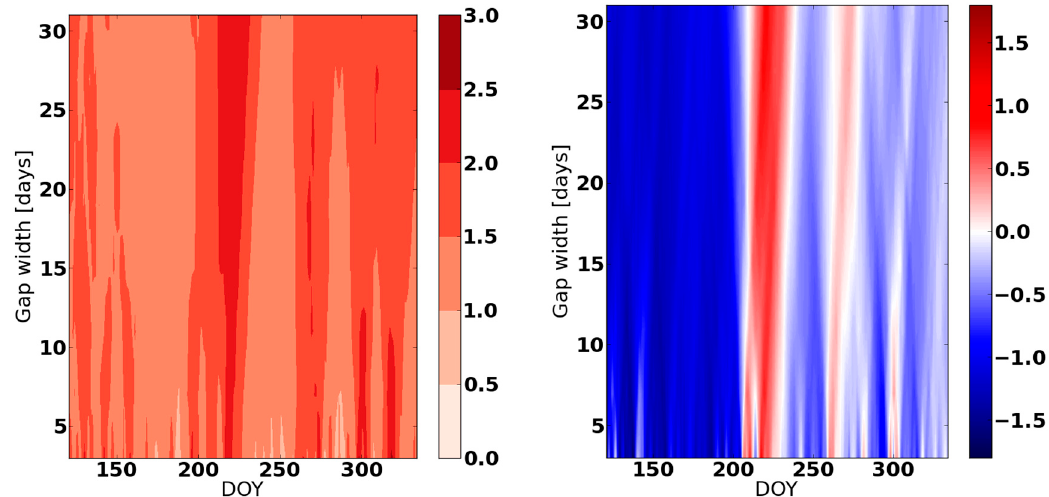
Figure 11. RMSE DEB ( left panel ) and (RMSE DEB -RMSE ERA5 ) difference ( right panel ) for DOY 121–334 in 2017 in Bahariya (Egypt).